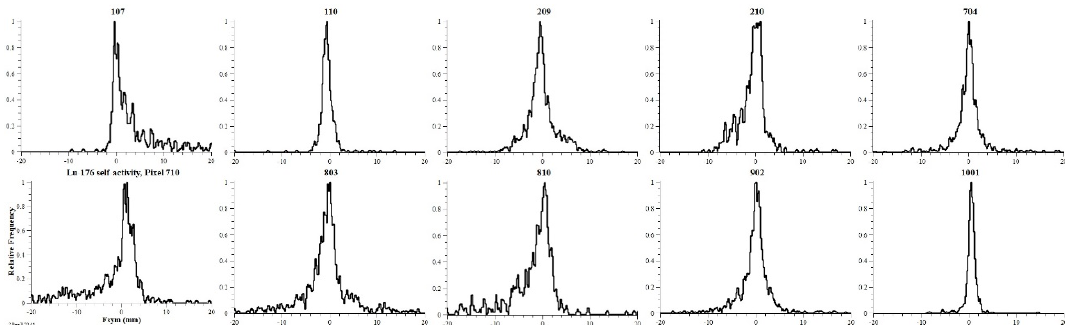
Figure 15. Fsym spectra from Lu-176 self-activity data regarding the selected decuple of pixels of the crystal-array with the best charge-symmetry response. Spectra are shown, from top-left to bottom-right, in ascending RRCC crystal-pixel order. Common axes titles and plot descriptions are reported only once in the bottom-left frame for better clarity. The selection criterion, based on Euclidian distances from origin in the plane (Average, Standard Deviation), founded the best decuple of zero-centered spectra made by pixels 107, 110, 209, 210, 704, 710, 803, 810, 902, and 1001, whose distance values from origin ranged from 0.45 to 1.37 mm.